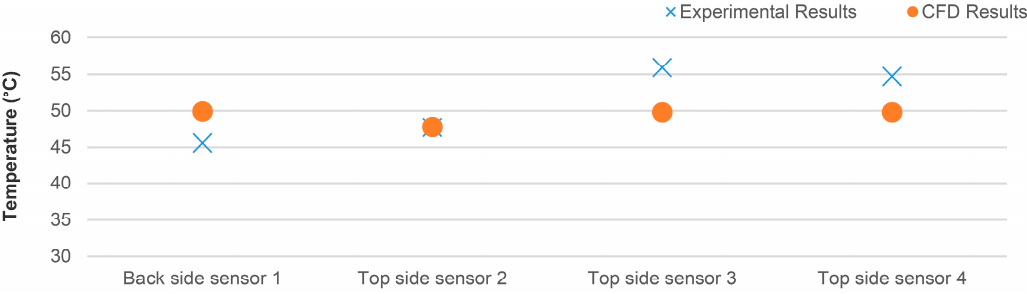
Figure 15. Measurement B: experimental results versus CFD results .